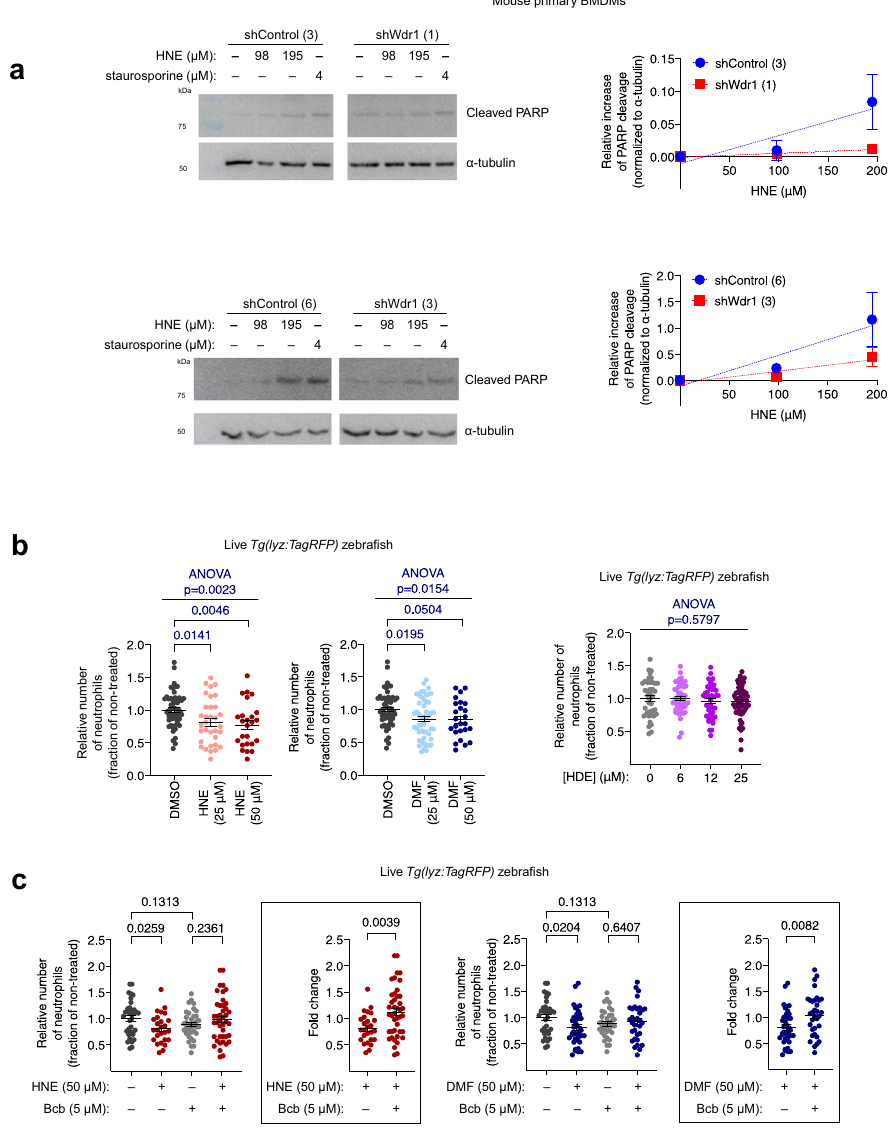
Fig. 4 Bulk exposure of mouse primary BMDMs and larval zebra fi sh to HNE/DMF triggers Bax-dependent macrophage/neutrophil apoptosis. a Left : western blots analyzing changes in the endogenous levels of cleaved PARP (hallmark of apoptosis) in two different pairs of lentiviral shWdr1-knockdown BMDMs and knockdown-control BMDMs, subsequent to HNE or staurosporine treatment (3 h). Right: ImageJ quanti fi cation of relative extent of cleaved PARP in HNE-treated, compared to the respective DMSO-control set, in Wdr1-knockdown BMDMs (red squares) vs. shControl (blue dots) lines. In each dataset, normalization was performed against α -tubulin loading control. Slopes from linear regression of shControl vs. shWdr1, Upper plot: 0.00043 ± 0.00012 and 0.00006 ± 0.00003, respectively. Lower plot: 0.0059 ± 0.0022 and 0.0023 ± 0.0008, respectively. Fits derived from fi tting to y = m x . b Tg(lyz:TagRFP) embryos expressing Halo-TEV-Keap1 were treated at 30 hpf with HNE or DMF or HDE for 6 h at indicated concentrations (up to maximum tolerable amount prior to cytotoxicity), and then neutrophils were counted. P values were calculated with ANOVA and Dunnett ’ s multiple comparisons test. Note that for the left two plots, the non-treated data are the same, but are presented in each plot for clarity. c Similar experiment as in ( a ) except with or without simultaneous administration of Bcb. Inset at right: Fold changes (treated/non-treated) in neutrophil counts. P values were calculated with two-tailed Student ’ s unpaired t -test. Note that the non-treated data are the same, but are presented in each plot for clarity. All data present mean ± SEM. All sample sizes are listed in Supplementary Methods. Source data are provided as a Source data fi carrying the Carmin allele, encoding a defunct Wdr1 protein 44 .